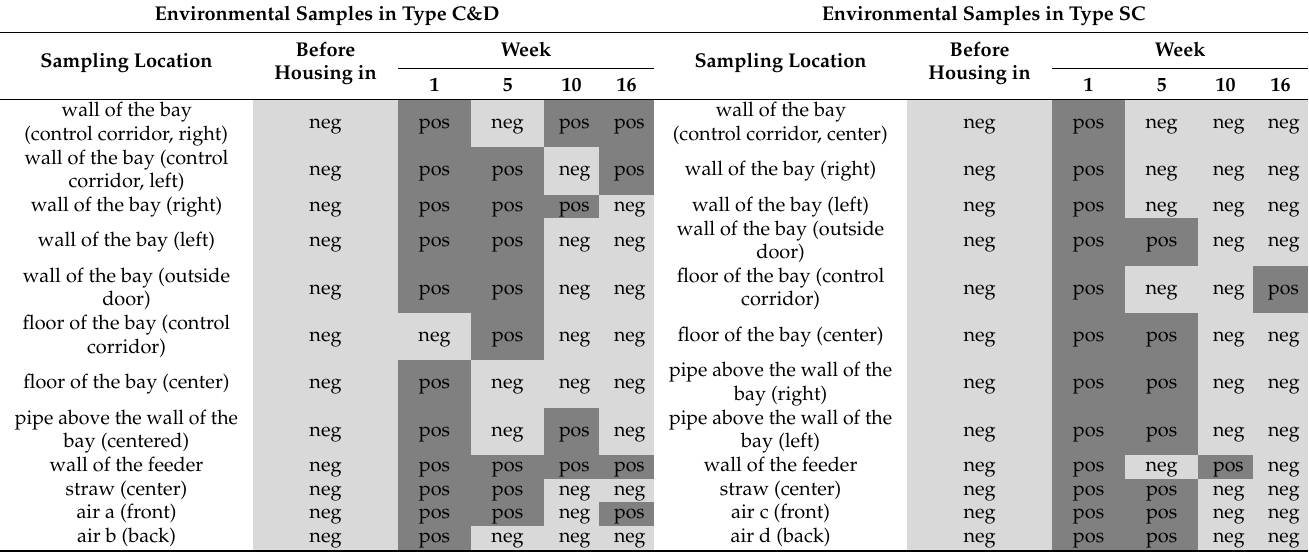
floor of the bay (control floor of the bay (center)